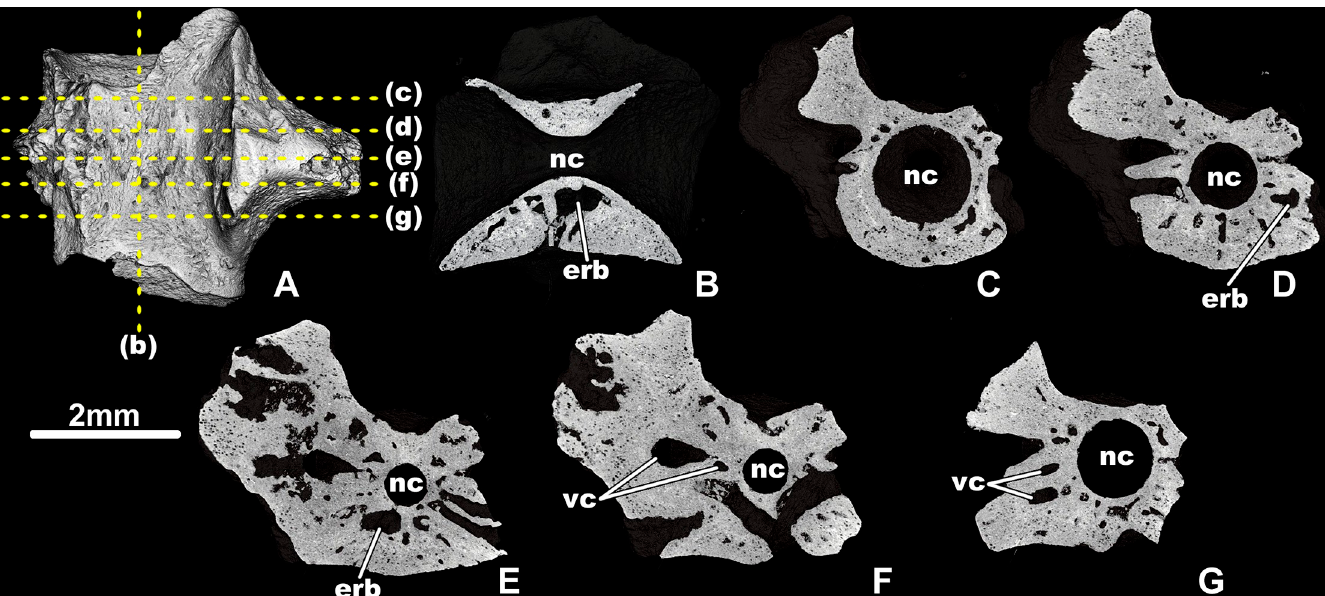
Fig 5. Egoria malashichevi gen. et sp. nov., digital restoration of trunk vertebra ZIN PH 32/144, entire specimen in dorsal view (A), showing locations of microCT digital sectionsin: longitudinal section in vertical plane (B) and transverse sections from anterior to posterior (C–G). Abbreviations: erb–erosion bay, nc–notochord canal, vc–vascular canal. All images showing digital sections at same